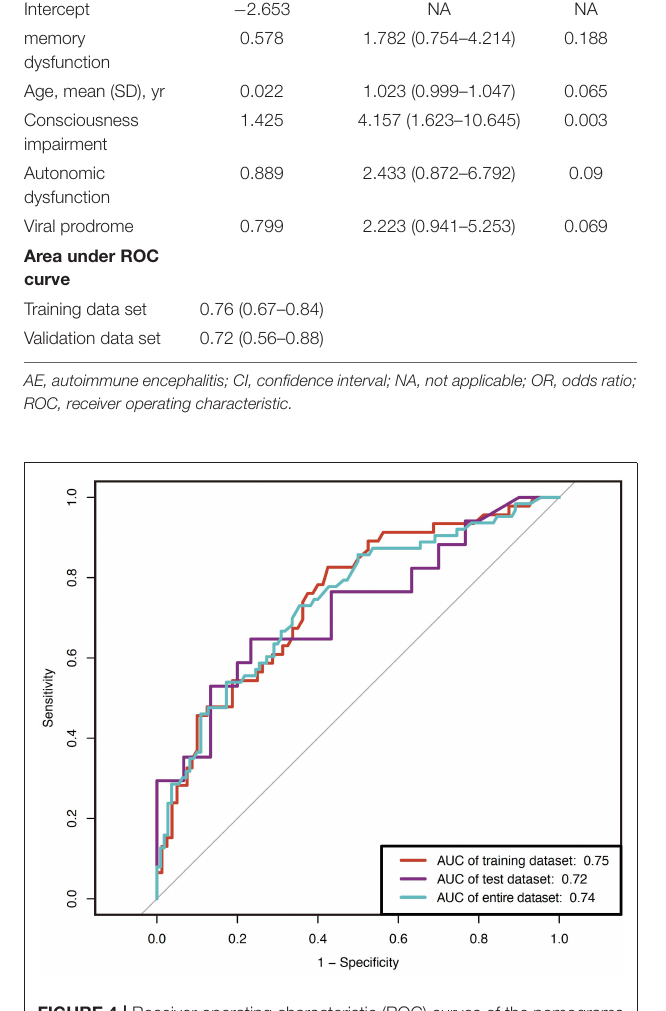
FIGURE 4 | Receiver operating characteristic (ROC) curves of the nomograms in the training data set, validation data set and all data. The nomogram had good discriminative power with an area under the ROC curve of 0.75 (95% CI: 0.66–0.84), 0.72 (95% CI: 0.56–0.88) and 0.74 (95% CI: 0.66–0.82) in the training data set, validation data set and all data, respectively.